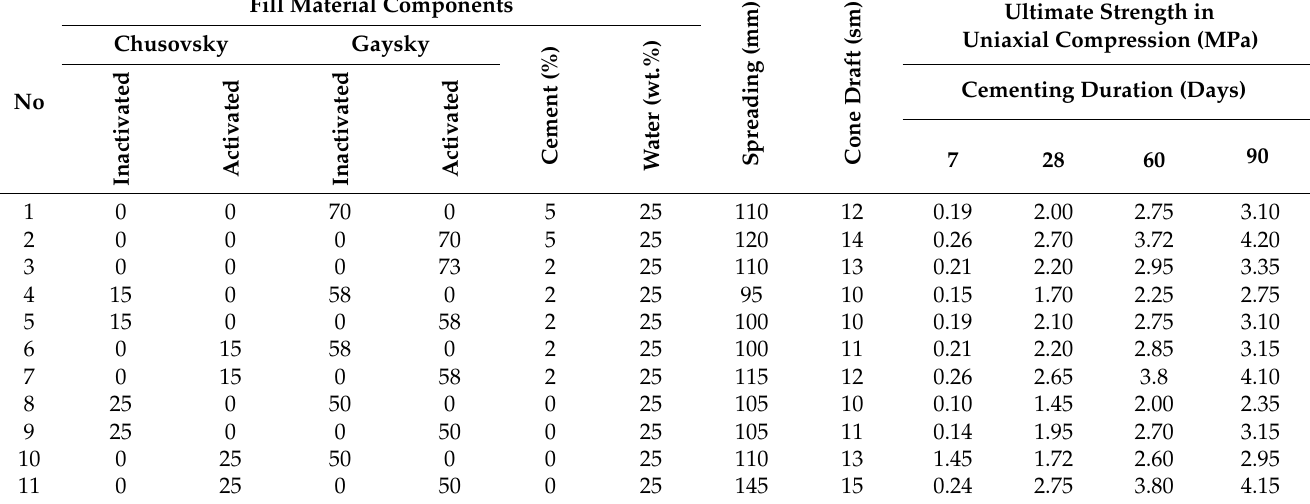
Table 4. Testing the fill